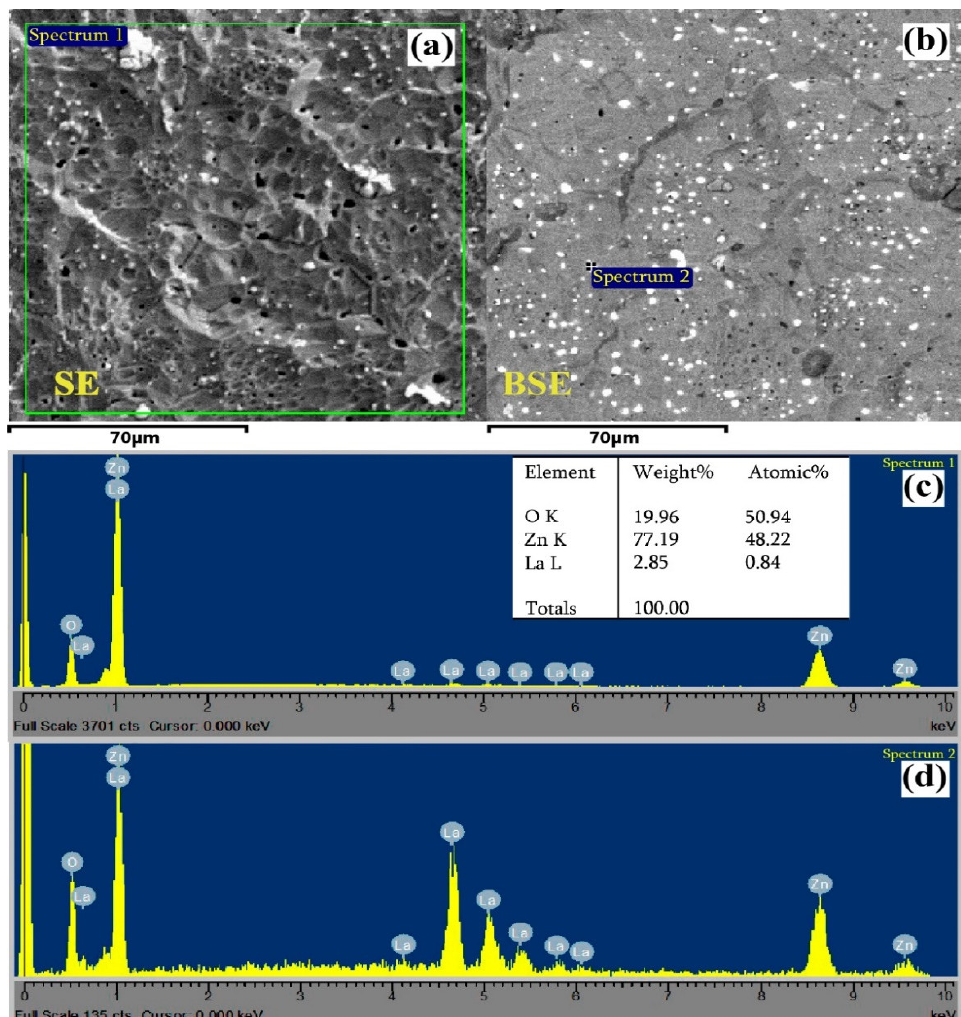
Figure 6. ( a ) SEM SE, ( b ) BSE plane-view and ( c , d ) EDX spectrum of the ZnO<La> material.